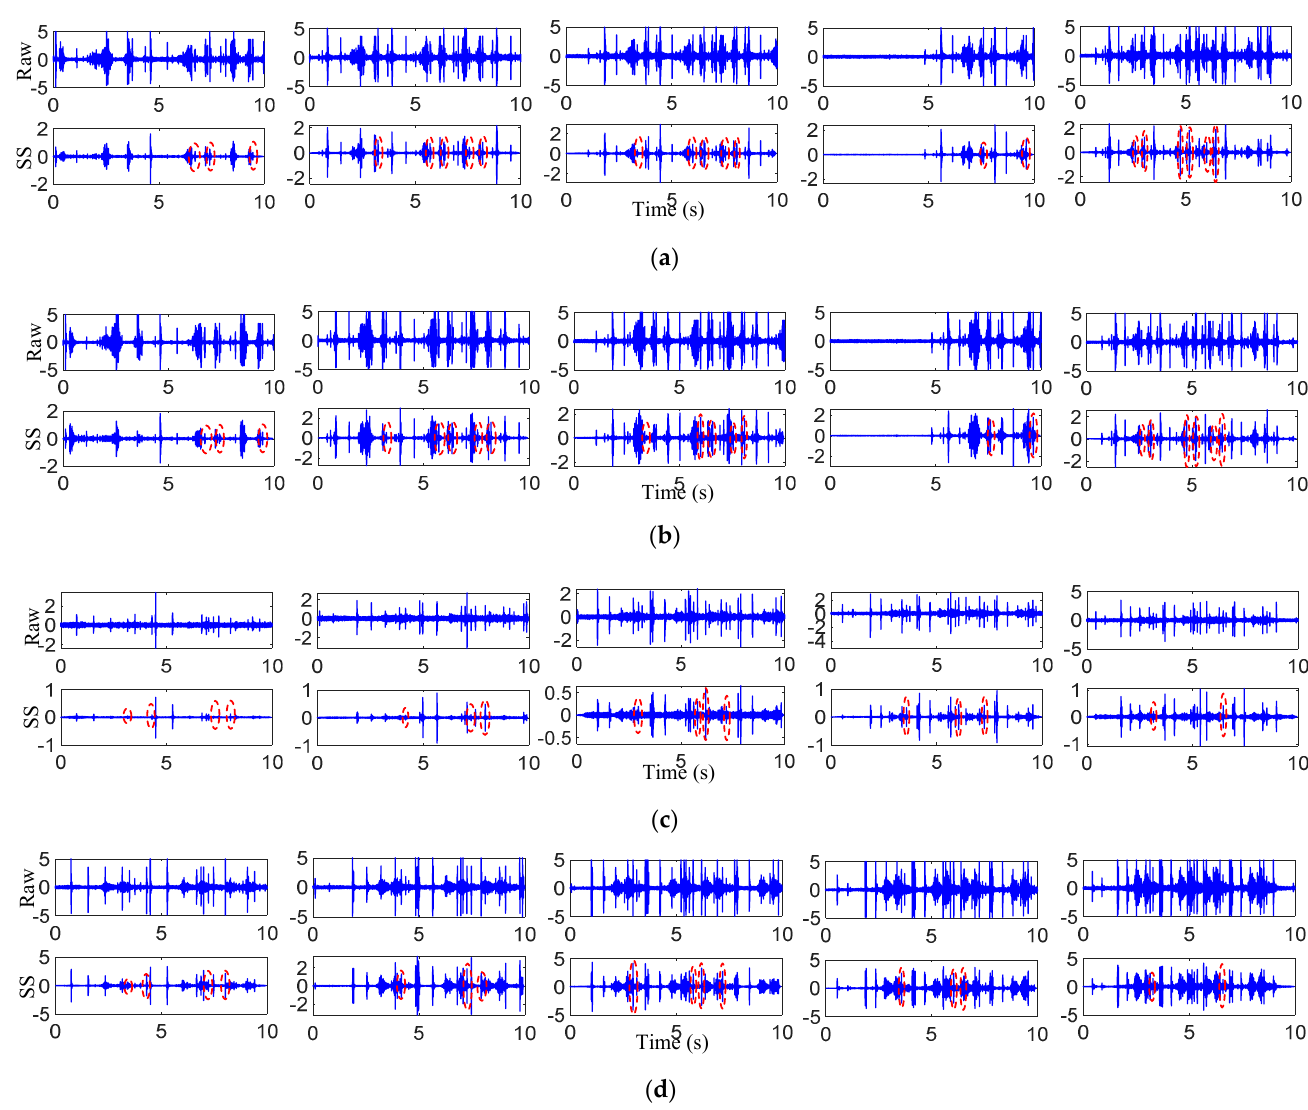
Figure 10. Extracted impact vibrations: ( a ) results of sensor 1 from damage 1; ( b ) results of sensor 2 from damage 1; ( c ) results of sensor 1 from damage 2; ( d ) results of sensor 2 from damage 2.